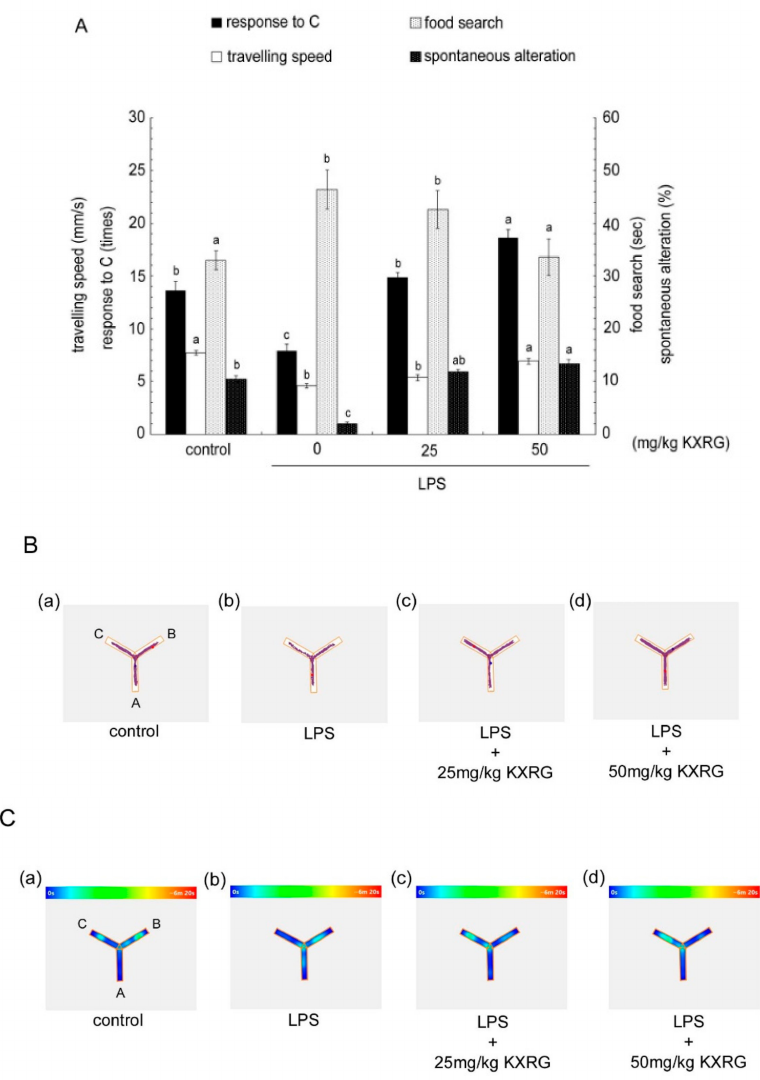
Figure 5. Effects of KXRG on brain cognitive impairments in mice with or without LPS treatment. ( A ) The y -axes indicate the different functional evaluations. Bars marked with different letters indi- cate statistically significant differences among groups at p < 0.05. ( B ) Mouse movement trajectory within 10 min. ( C ) Time spent by mice in each zone ( A – C ) within 10 min. Colors as shown at the top of the image. Time increases from blue to